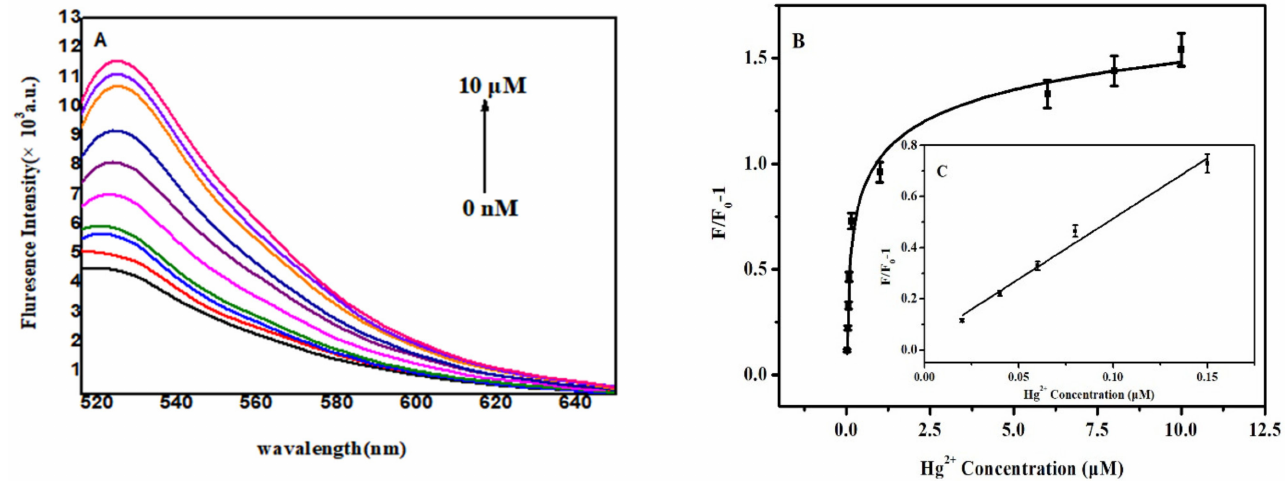
Figure 2. ( A )The fluorescence intensity of GO-DNA sensor (probe 2) after adding different concentrations of Hg 2+ . ( B ) The value of F/F 0 -1 after adding different concentrations of Hg 2+ . F and F 0 were the fluorescence intensity of after adding Hg 2+ , and before adding Hg 2+ . ( C ) The illustration showed a linear relationship between low concentrations of Hg 2+ and F/F 0